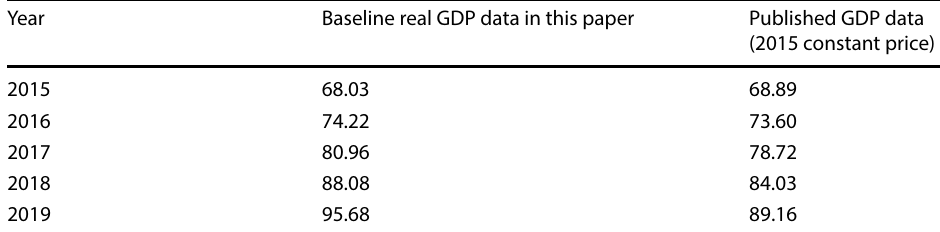
Table 1 The comparison of the baseline real GDP and published GDP